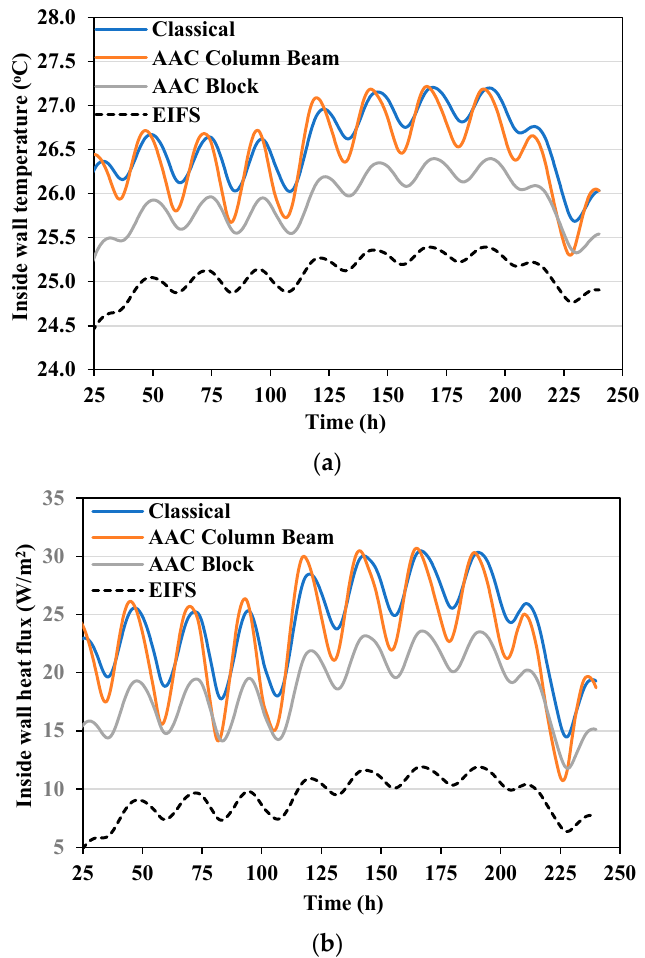
Figure 5. Inside wall temperature and heat flux of the thermal bridges of the intermediate floors using tested four walls. ( a ) inside wall temperature, ( b ) inside heat flux.